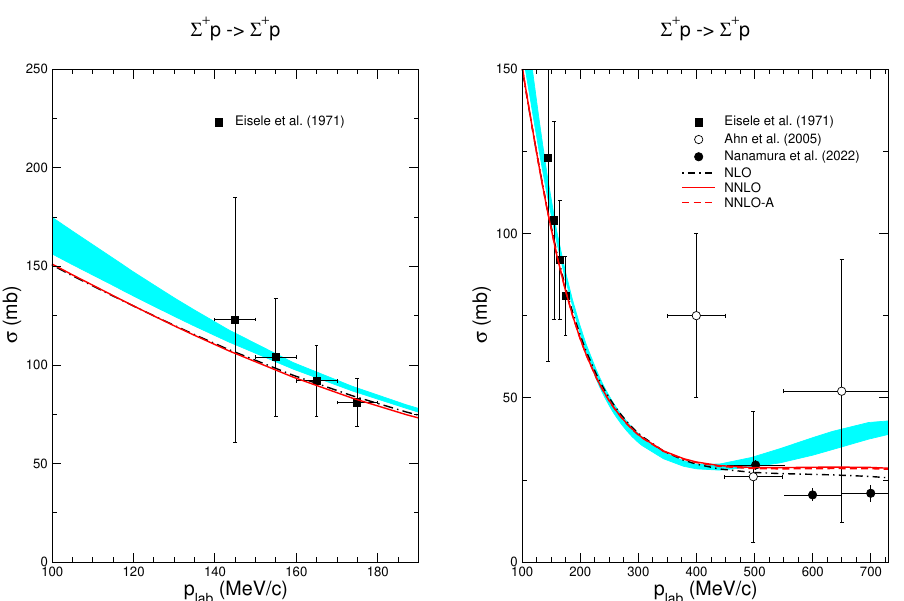
Figure 1. Cross section for Σ + p scattering as a function of p lab . Results are shown for the SMS NLO (dash-dotted) and N 2 LO (solid) YN potentials. The dashed line corresponds to an alternative fi t at N 2 LO, see text. The cyan band is the result for NLO19 [4]. Data are from the E40 Collaboration [23] and from Refs. [28,